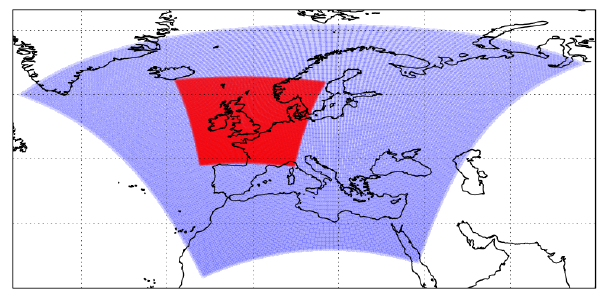
Figure 1. Nested modelling domains. The rectangular boundary of the figure is an extract of the GCCM (resolution 140km) contain- ing the RCCM domain (resolution 50km) plotted in blue and the AQUM domain (resolution 12km) in